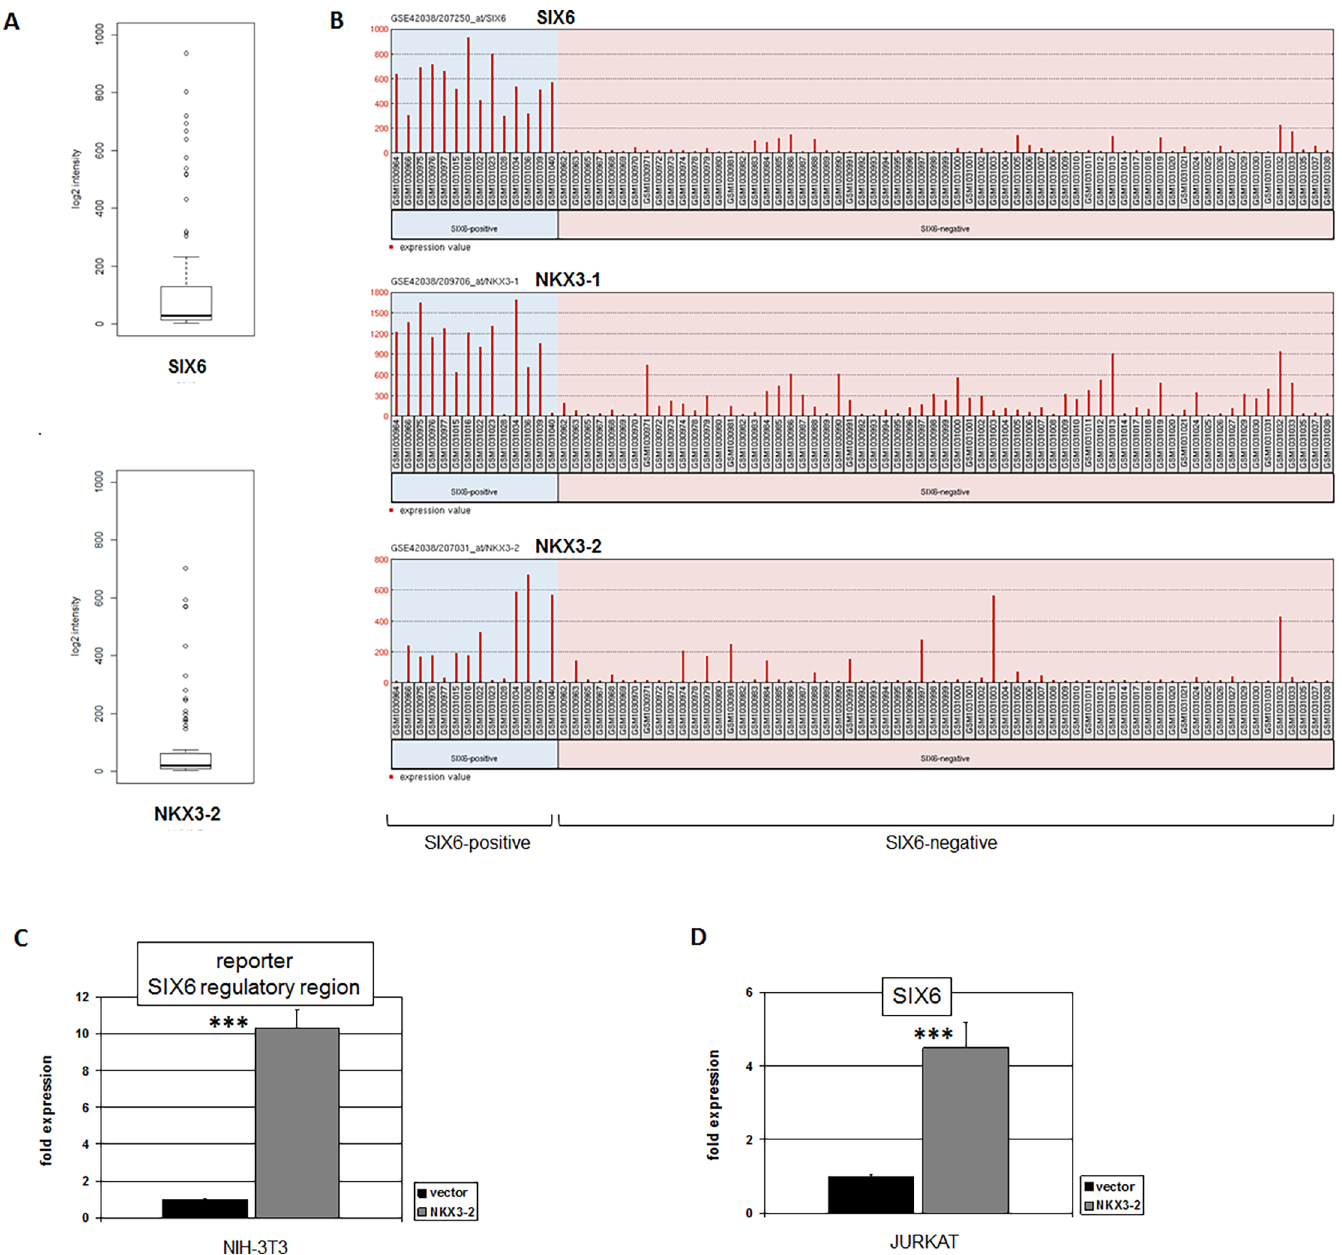
Fig 1. Expression and regulation of SIX6 in T-ALL. (A) Boxplots show expression data from T-ALL dataset GSE42038 for SIX6 (above) and NKX3-2 (below). Patient samples exhibiting gene overexpression are indicated by circles totaling 13/79 (16%) for SIX6 and 14/79 (18%) for NKX3-2. (B) Expression levels of SIX6, NKX3-1 and NKX3-2 for pediatric T-ALL patients obtained from dataset GSE42038 are ranked according SIX6-overexpression and control remainders. (C) Reporter gene assay using a genomic fragment from the SIX6 gene containing a confirmed NKX3-1 binding site demonstrated direct activation of SIX6 by NKX3-2 in NIH-3T3 cells. (D) Forced overexpression of NKX3-2 in JURKAT cells resulted in enhanced expression levels of SIX6 as analyzed by